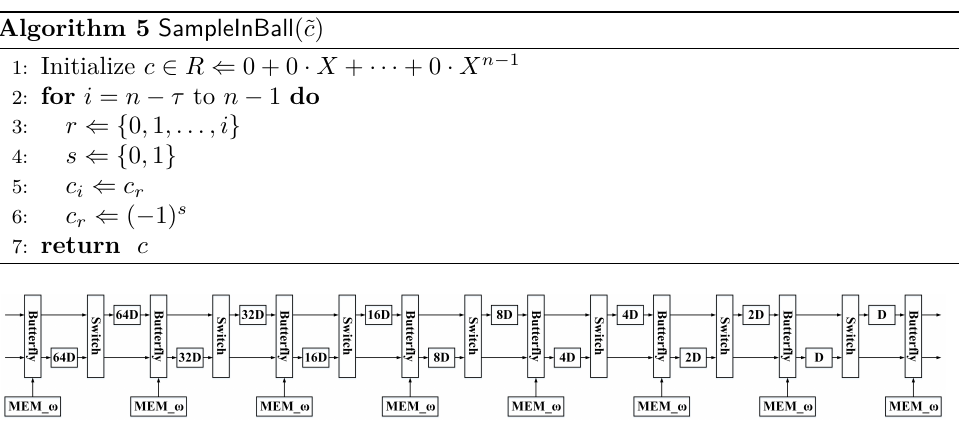
Algorithm 5 SampleInBall (˜ c )